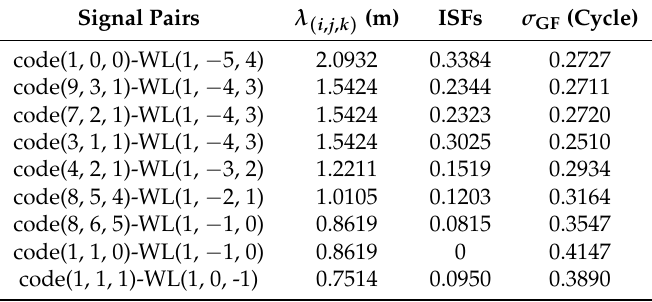
Table 3. The wavelength, ISFs and the measurement noise of the code-WL signal pairs for GF